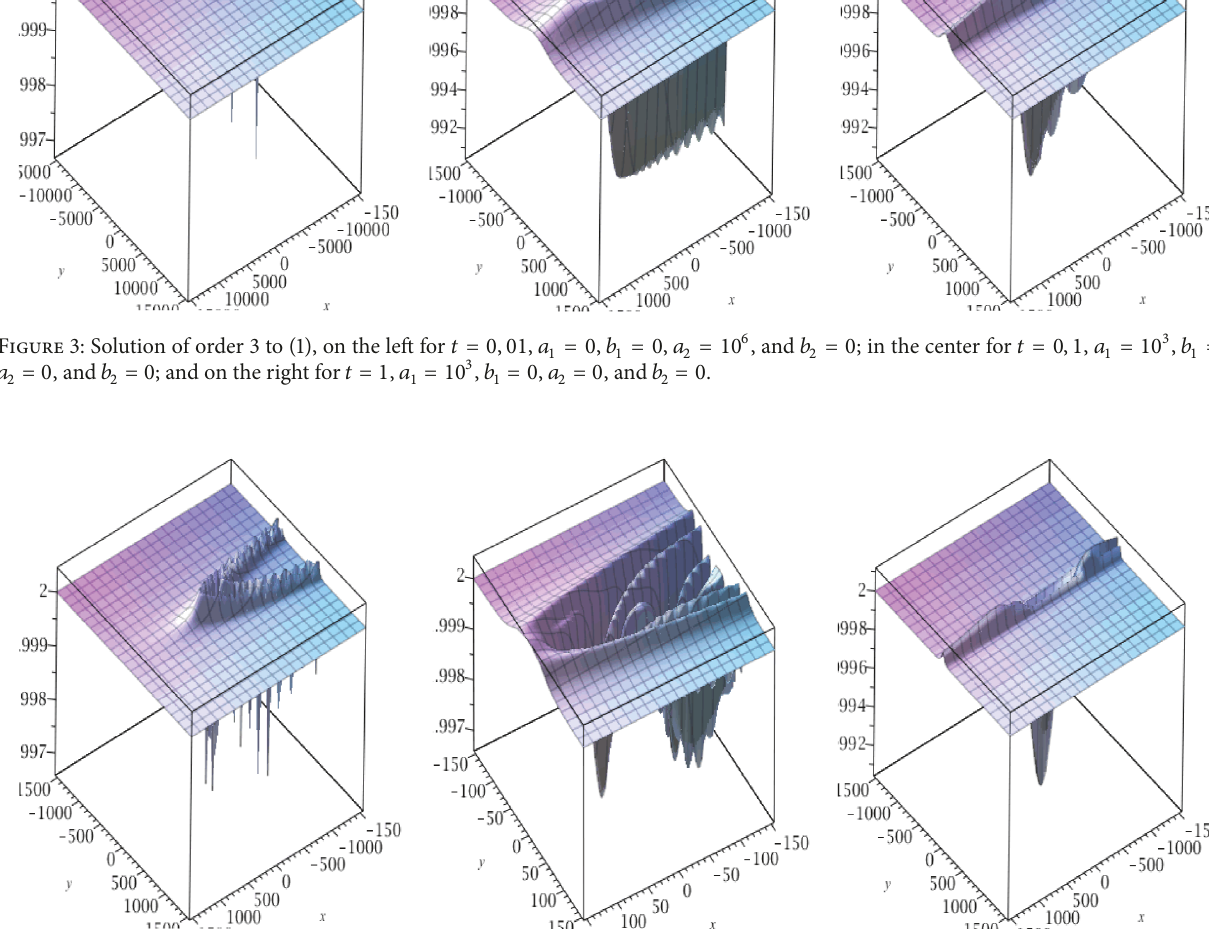
+ 1964395250759761920𝑡 2 −